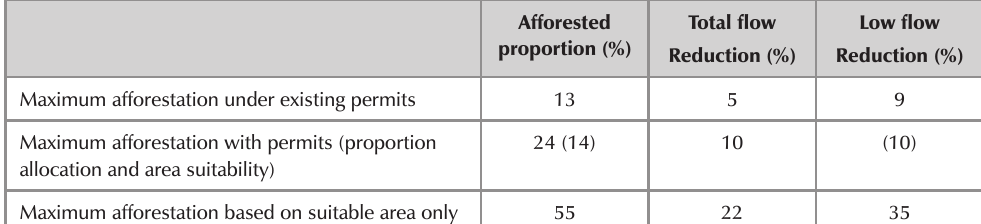
Percentage area of Underberg district afforested, reduction in total and low flows under different